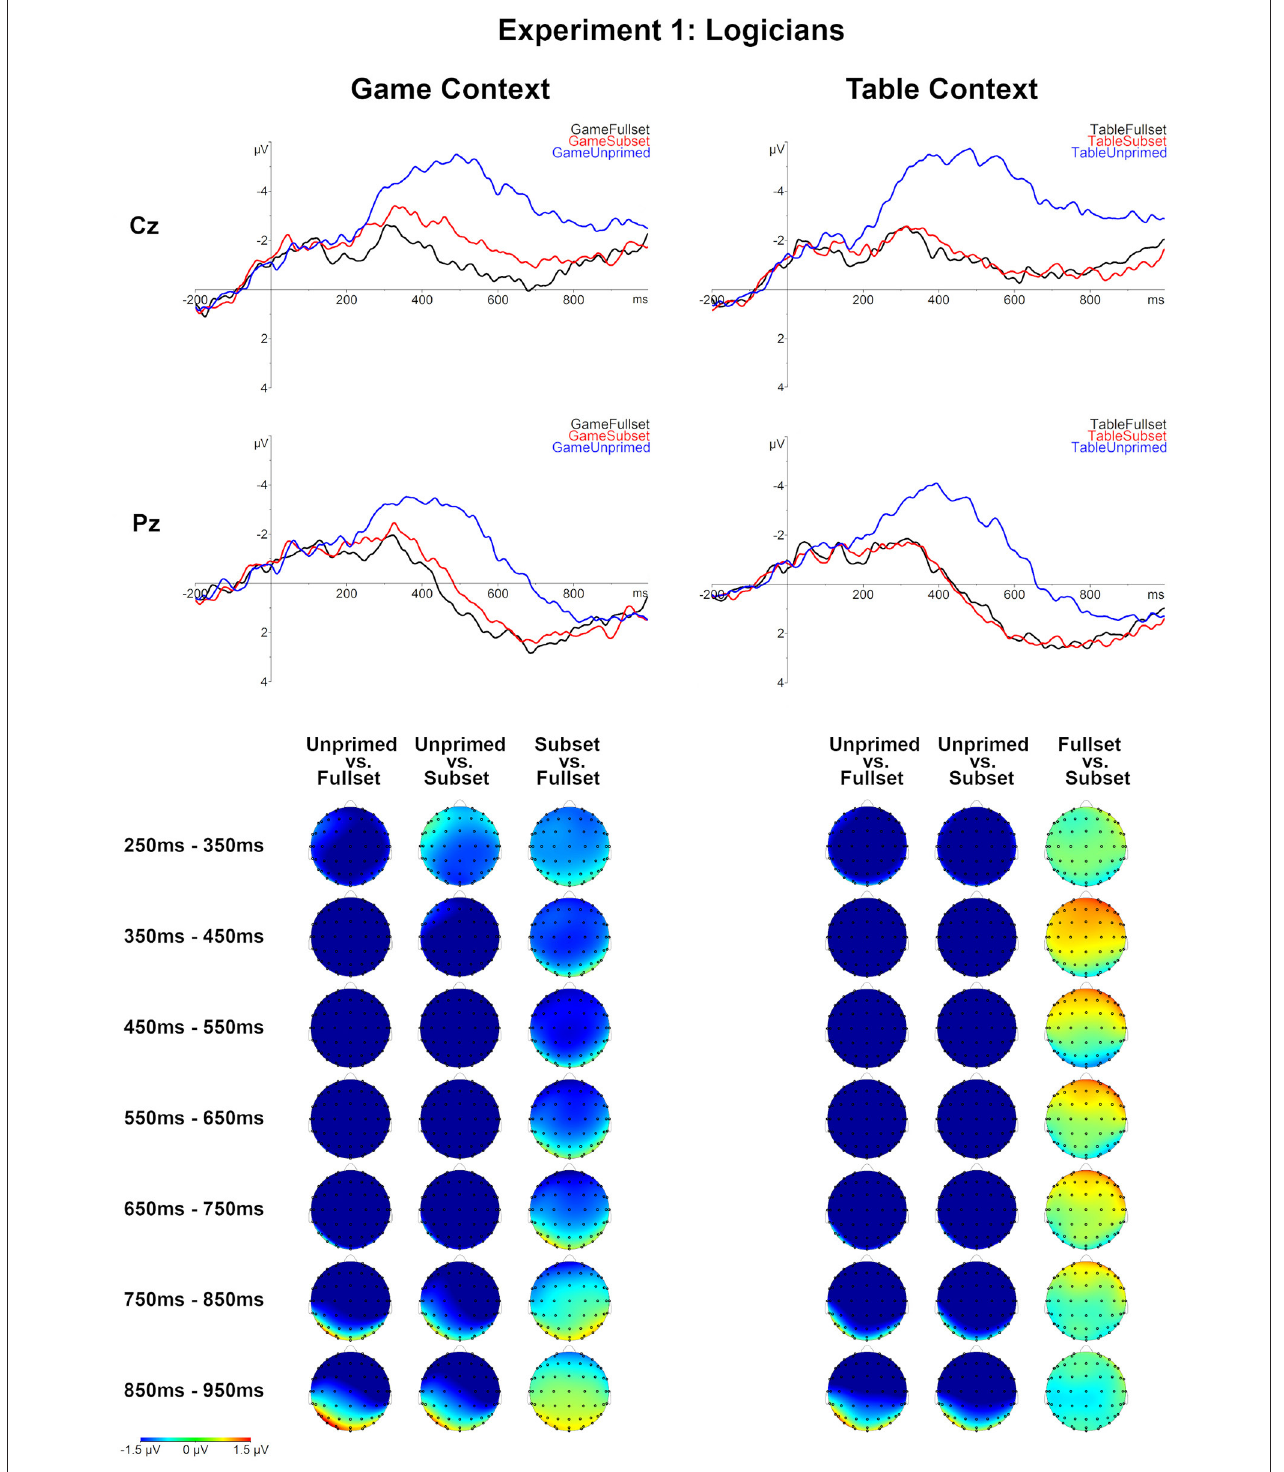
FIGURE 4 | Grand averages for all conditions for logicians ( N = 33), Experiment 1. Topographical maps of the differences between the compared Set levels separately for the Table and Game context in consecutive 100 ms time-windows, between 250 and 950 ms post-onset.